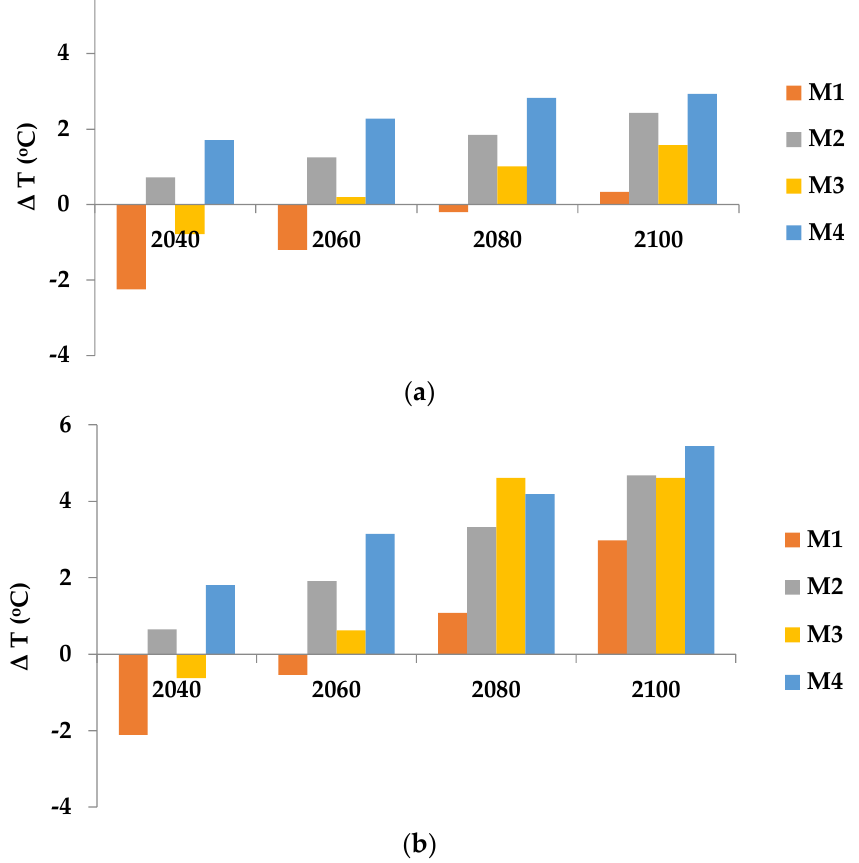
Figure 10. ΔT values for Tmax using four climate models under ( a ) SSP2-4.5 and ( b ) SSP5-8.5.